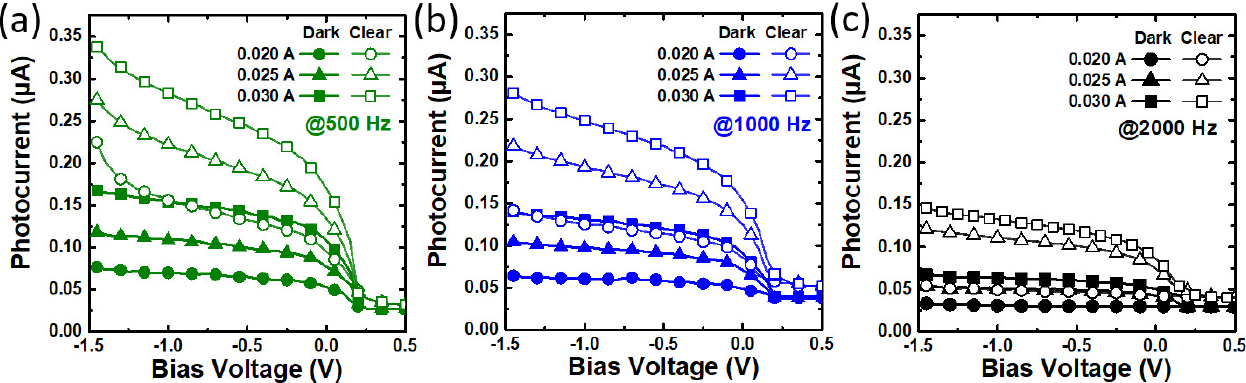
Figure 2. PC-V curves of IGZO LAPS with clear and dark zones defined by the SU8–2005 layer measured in a pH 7 standard buffer solution with various trigger currents, including 0.020, 0.025 and 0.030 A and 405 nm laser modulated with AC frequencies of ( a ) 500, ( b ) 1000 and ( c ) 2000 Hz.